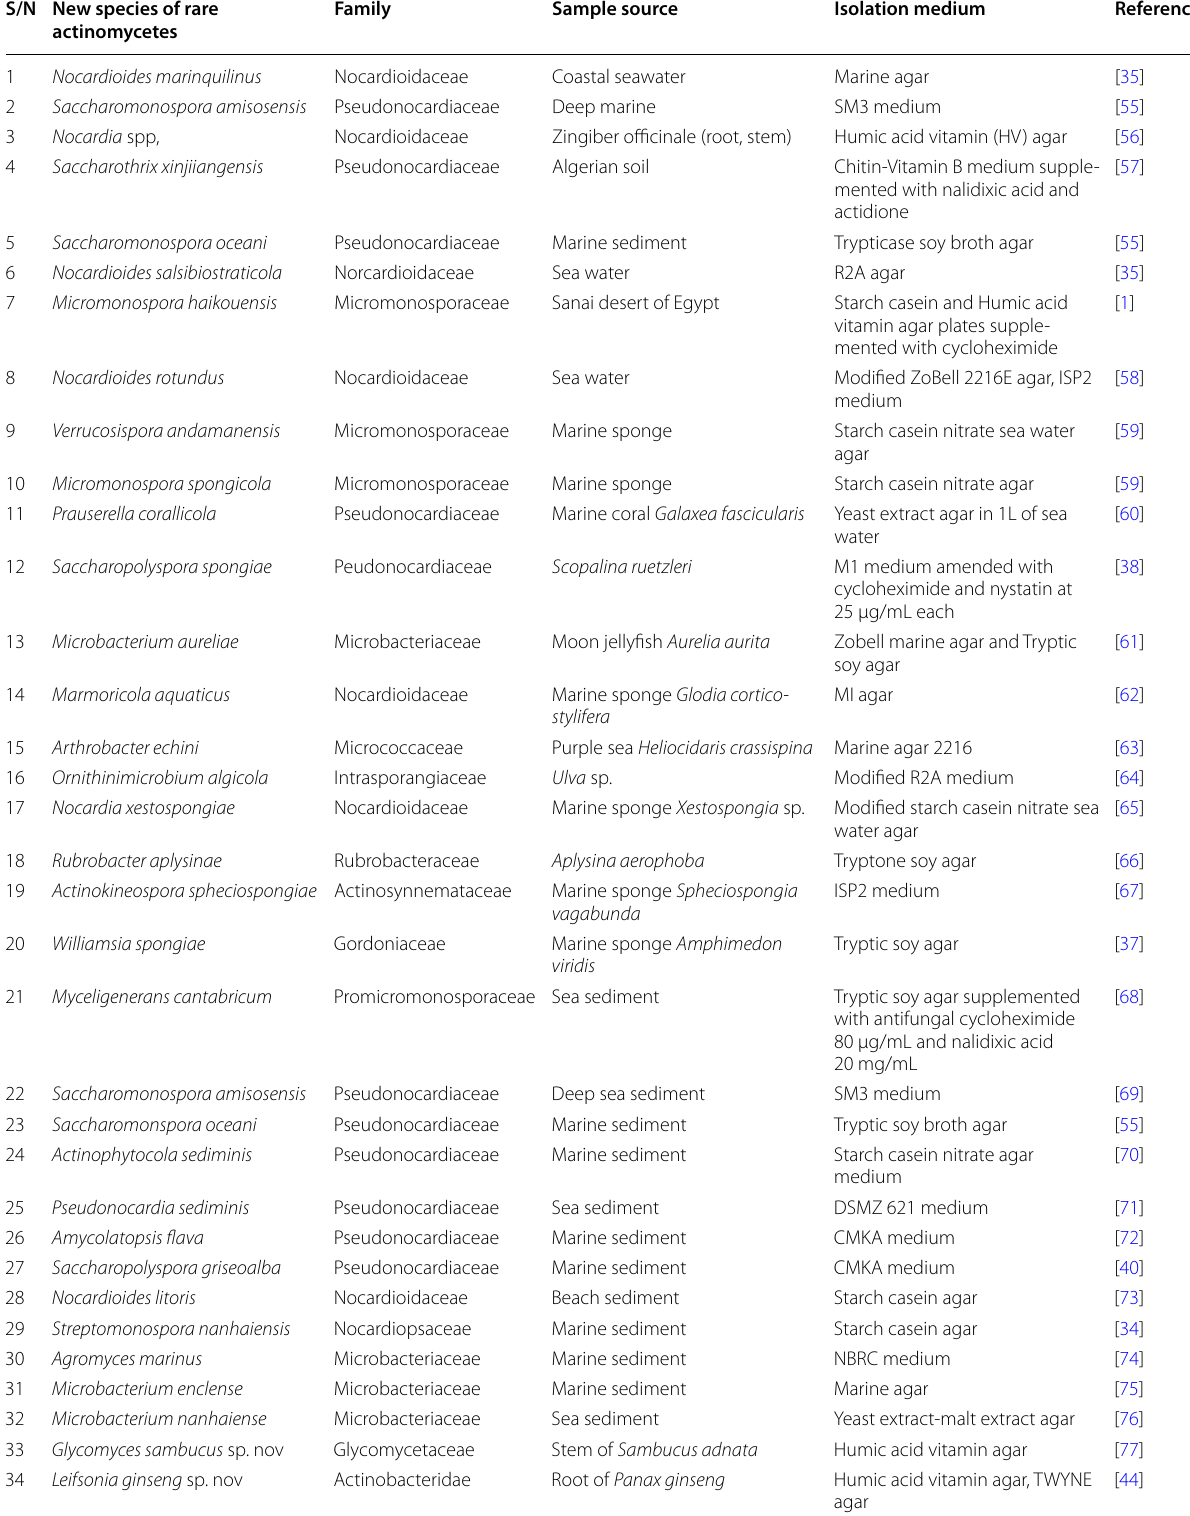
Table 1 Different rare actinomycetes and their isolation media S/N New species of rare actinomycetes